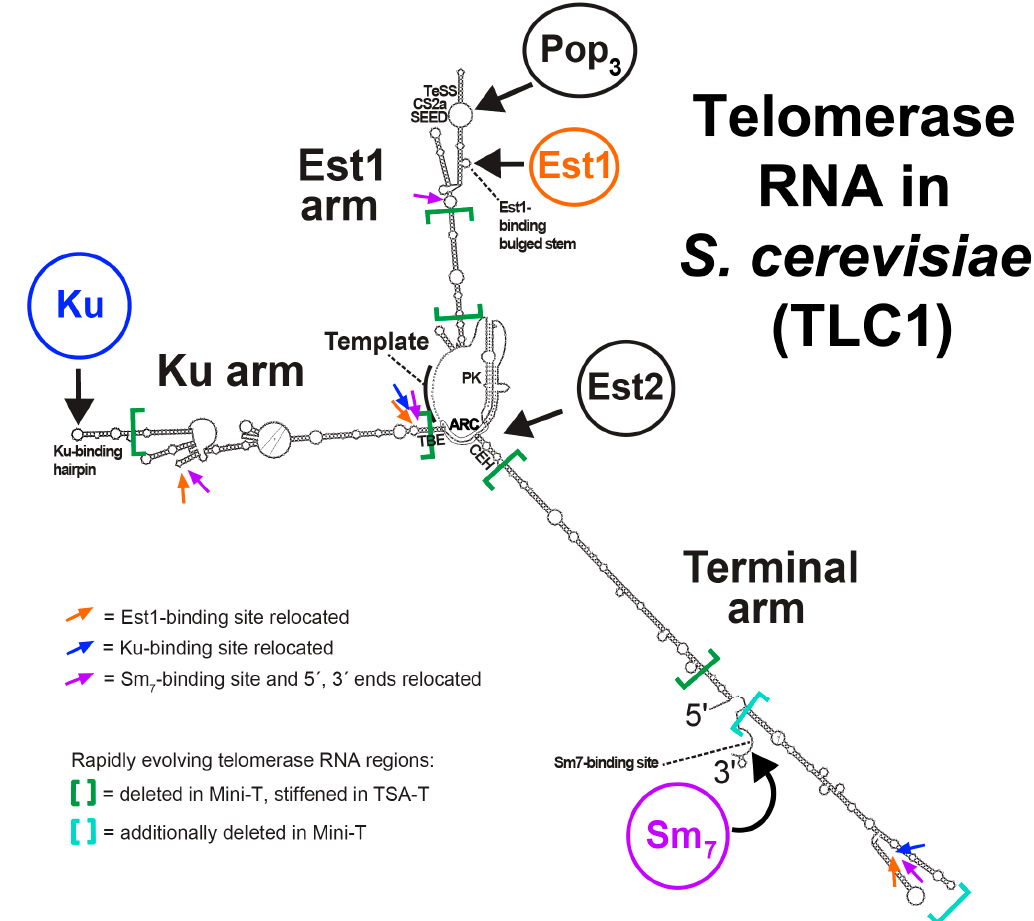
Figure 1. The Saccharomyces cerevisiae telomerase RNA: a paradigm for RNA as a flexible scaffold of a large RNP. Shown is the secondary structure model reported originally [13] along with the dynamic pseudoknot (PK) region in the central core, which was worked out in detail over the following decade [18–22]. Positions used for moving the binding sites for the Est1 [13], Ku [23], and Sm subunits (along with the RNA ends) [24] are indicated by colored arrows. Large green brackets indicate the rapidly evolving regions, which were deleted, in the case of making the miniaturized TLC1 allele Mini-T [25], or stiffened, in the case of triple-stiff-arm TLC1 (TSA-T) [26]. Thus, it is the regions outside of the brackets that are the more conserved modules that tend to bind to proteins at